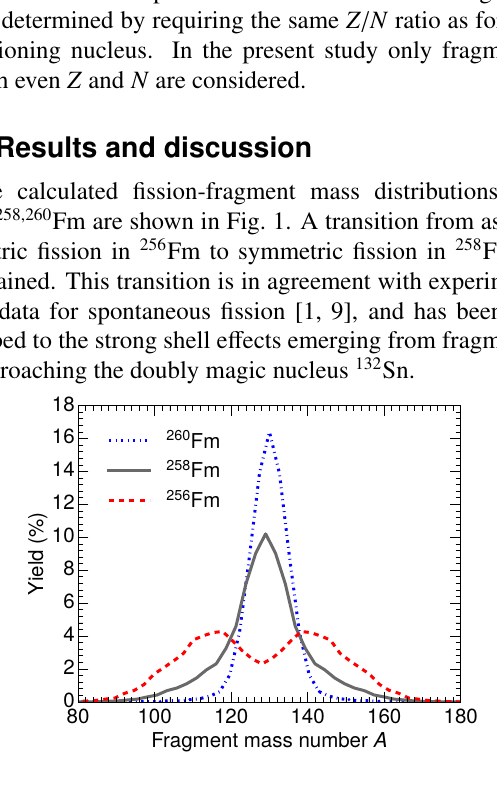
Figure 1. Calculated fission-fragment mass yields for the fer- mium isotopes 256 , 258 , 260 Fm.